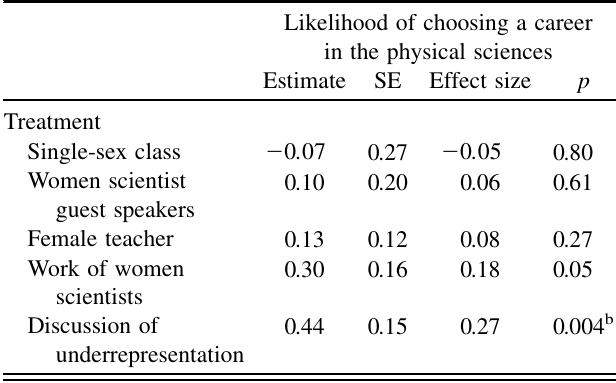
FACTORS THAT AFFECT THE PHYSICAL SCIENCE . . TABLE II. T -test difference between treatment and control groups after matching for each of the five conditions. (SE, standard error.)